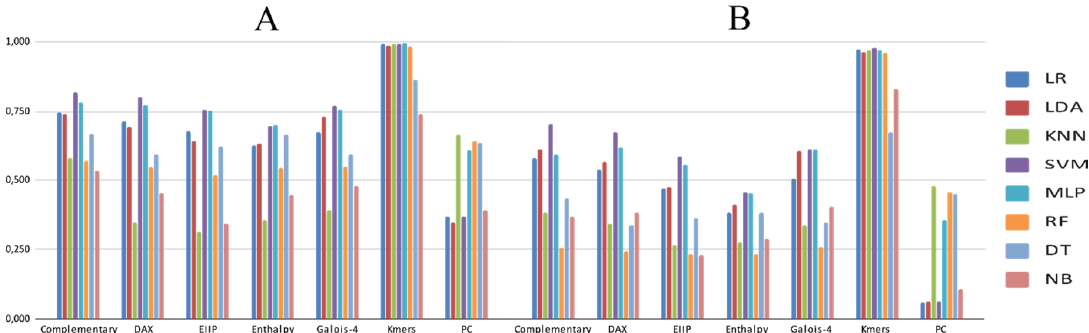
Figure 2. Performance of machine learning (ML) algorithms and Repbase pre-processed data by principal component analysis (PCA) and scaling processes using as main metric: ( A ) accuracy and ( B ) F1-score.